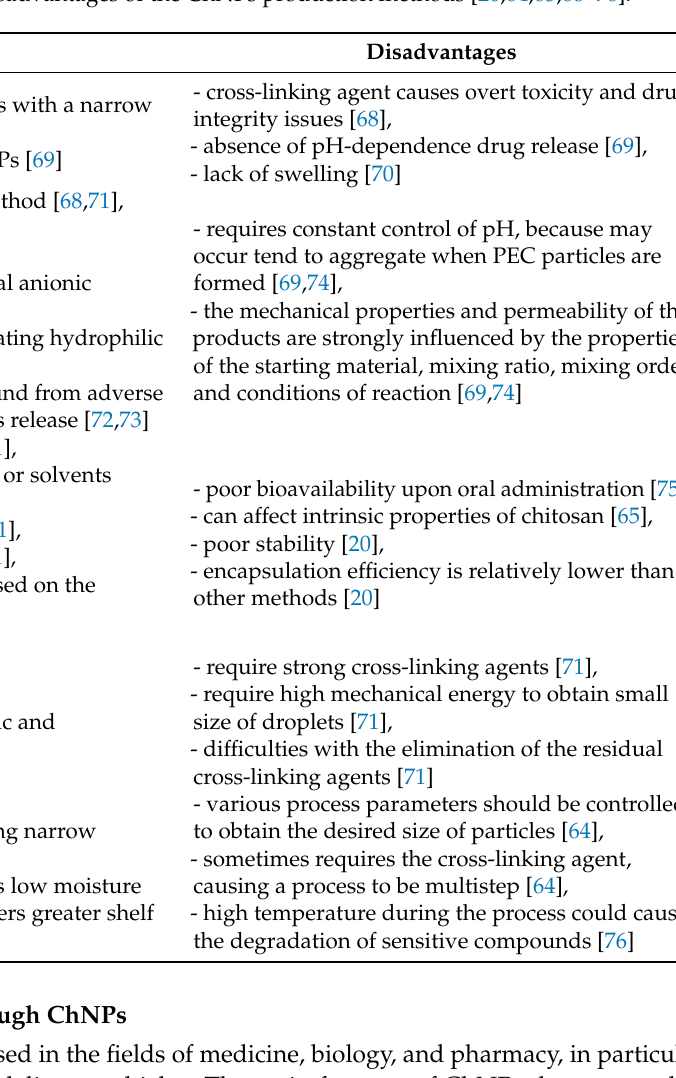
Table 2. Advantages and disadvantages of the ChNPs production methods